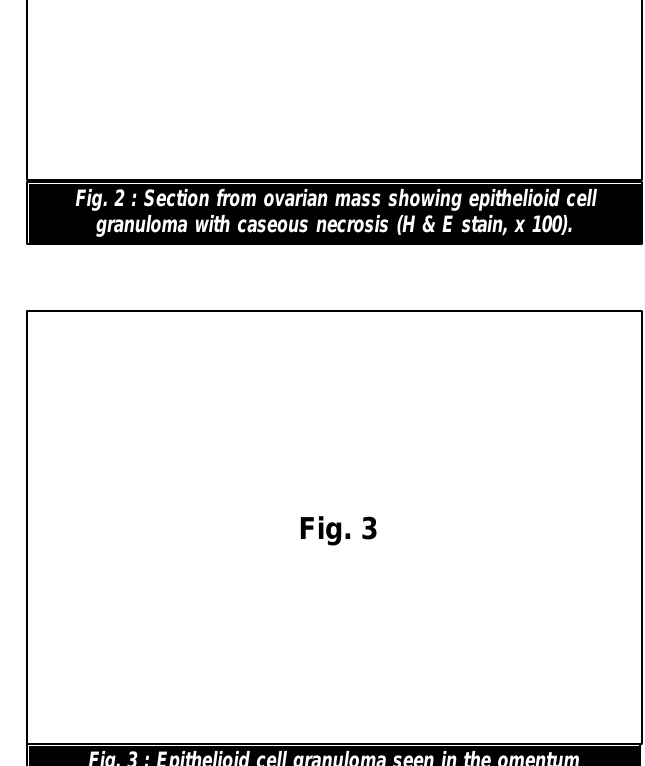
Fig. 3 : Epithelioid cell granuloma seen in the omentum (H & E stain, X